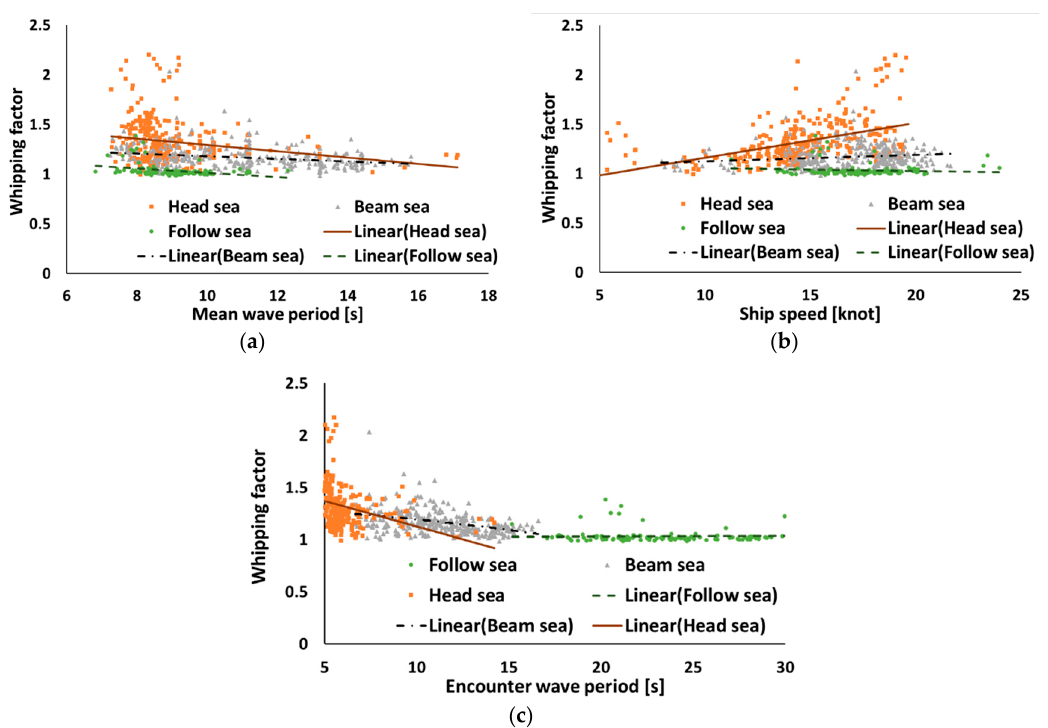
Figure 8. Comparison of whipping factor and ( a ) mean wave period, ( b ) ship speed, ( c ) encounter wave period.